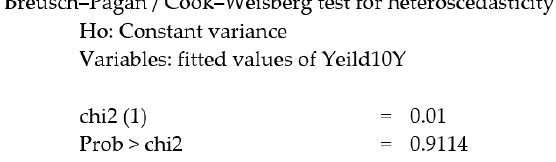
Figure 4. The results of Breusch–Pagan test.